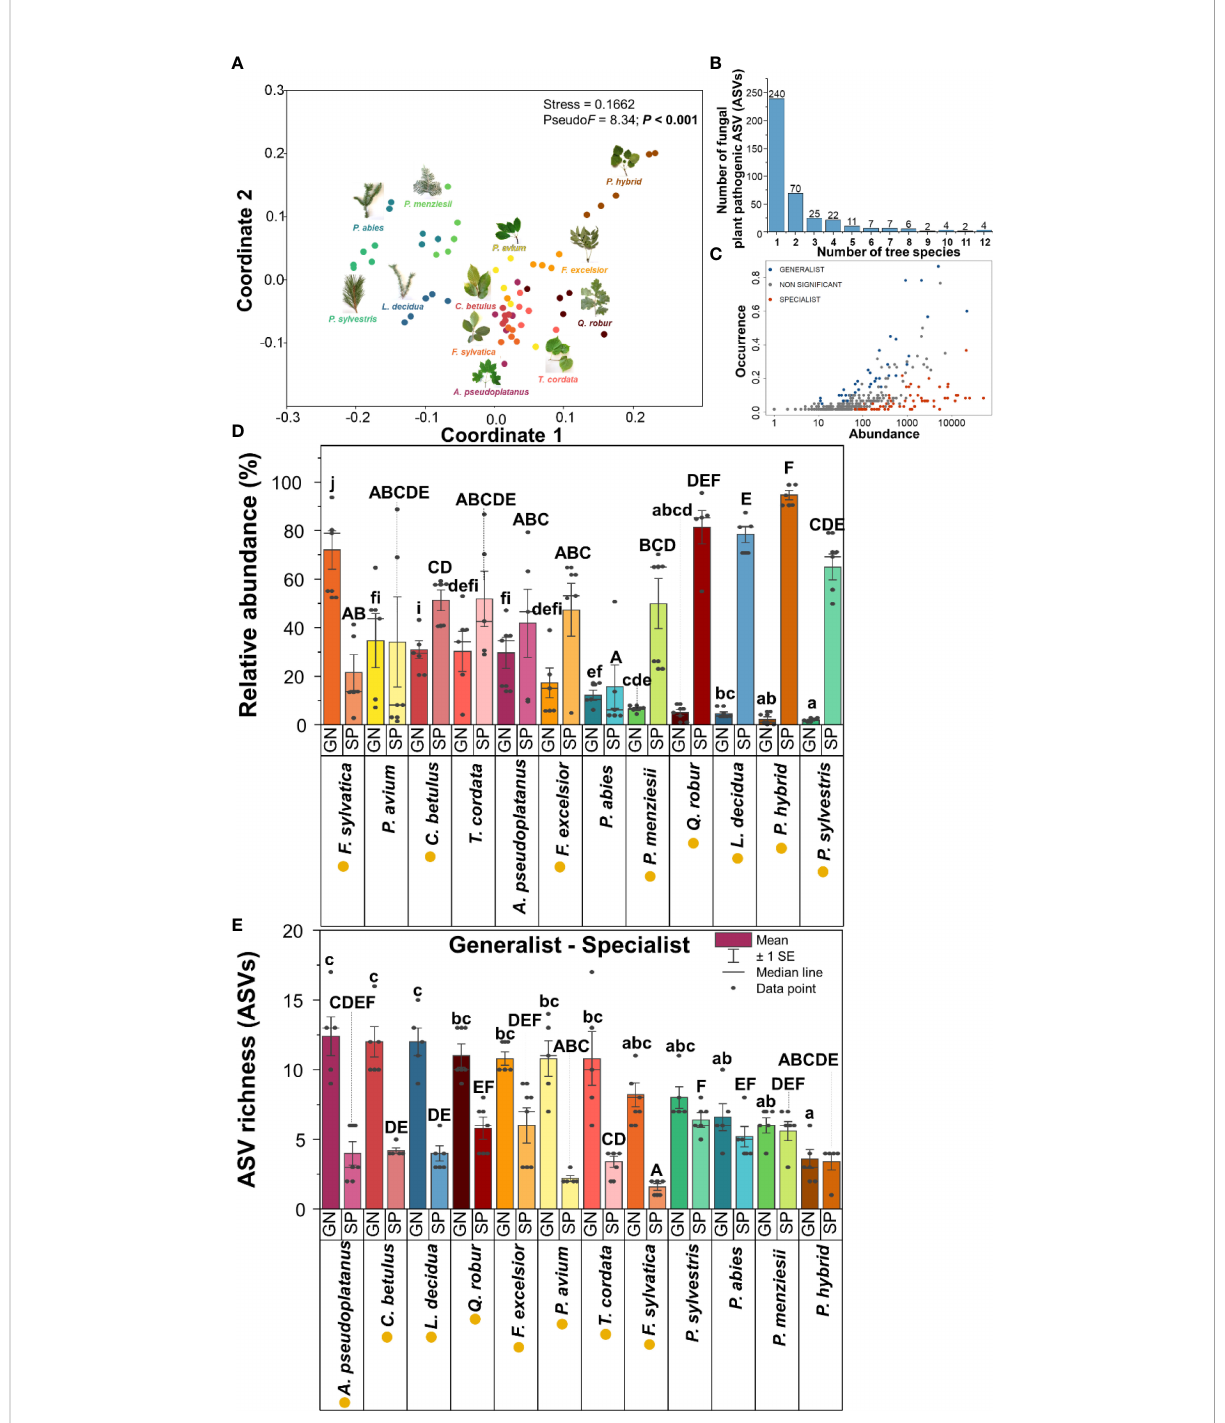
FIGURE 3 Fungal plant pathogenic community compositions and their speci fi city: NMDS ordinations of fungal plant pathogenic community compositions based on relative abundance and Bray – Curtis distance similarity (A) , number of fungal plant pathogenic ASVs detected in various number of tree species (B) , the abundance and the occurrence of generalists and specialists of fungal plant pathogens (C) , relative abundance (D) , and ASV richness (E) of fungal plant pathogenic generalists and specialists in each tree species. Generalist and specialist classi fi cation refers only to our taxonomic data from this local scale experiment. Capital and lowercase letters in panels (D, E) indicate statistically signi fi cant differences (Kruskal – Wallis test and ANOVA were performed for the data sets with non- and equality of variance, respectively) among fungal plant pathogenic specialists (SP) and generalists (GN), respectively. The yellow circle in the front of tree species name indicates statistically signi fi cant differences ( t -test) between fungal plant pathogenic generalist and specialist in each tree